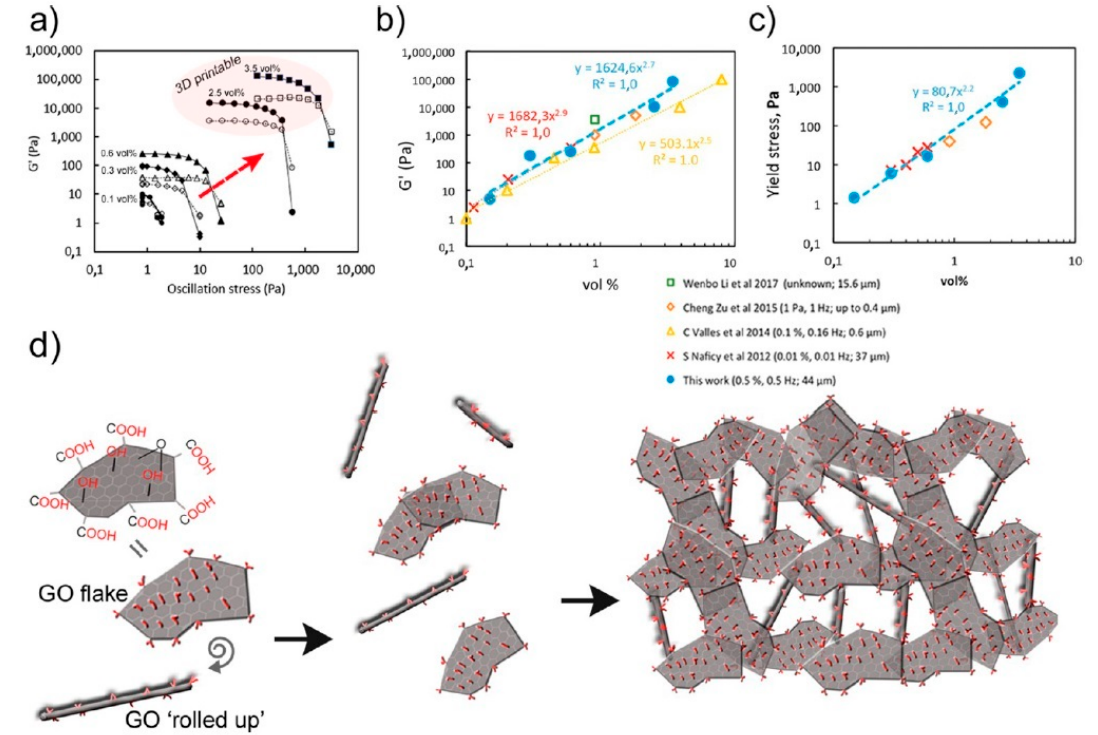
Figure 24. Viscoelastic behavior of pastes and GO suspensions: Storage Modulus (G ′ ) vs. Oscillation Stress ( a ), and GO concentration influence on G ′ ( b ), and yield stress ( c ). The proposed network created by GO flakes as concentration increases ( d ). A part of GO sheets form GO scrolls that together with the sheets bring together forming a 3D liquid crystal structure with high G ′ ( a ). Reproduced from [29], with permission from American Chemical Society, 2017.